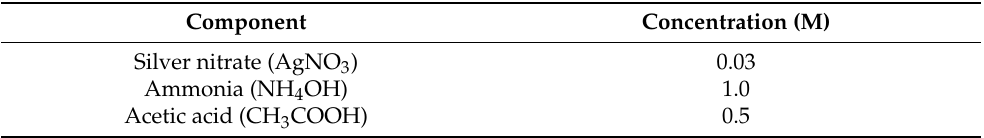
Table 2. The electroless silver bath composition. Adapted with permission from [26,42].